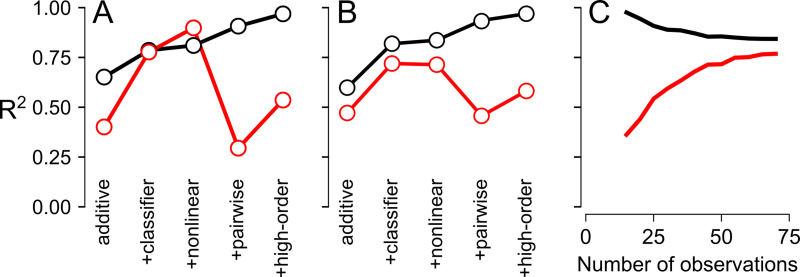
The additive+classifier+nonlinear model captures the most variation without over-fitting.In all panels, the lines denote R2train (black) and R2test (red). In panels A and B, the complexity of the model increases from left to right: additive model, plus classifier, plus a nonlinear spline, plus pairwise epistasis, and plus high-order epistasis. A) R2train was calculated from the 52 phenotypes used to train the model and R2test was calculated from the 24 newly-measured phenotypes. B) R2train was calculated for pseudoreplicate training sets of 52 genotypes sampled from the 76 characterized genotypes, with R2test calculated from the matched 24-genotype test datasets. C) The means of R2train and R2test converge as the number of observations in the pseudoreplicate training sets increase, reaching a plateau at ~60 genotypes (calculated with the additive+classifier+nonlinear model).